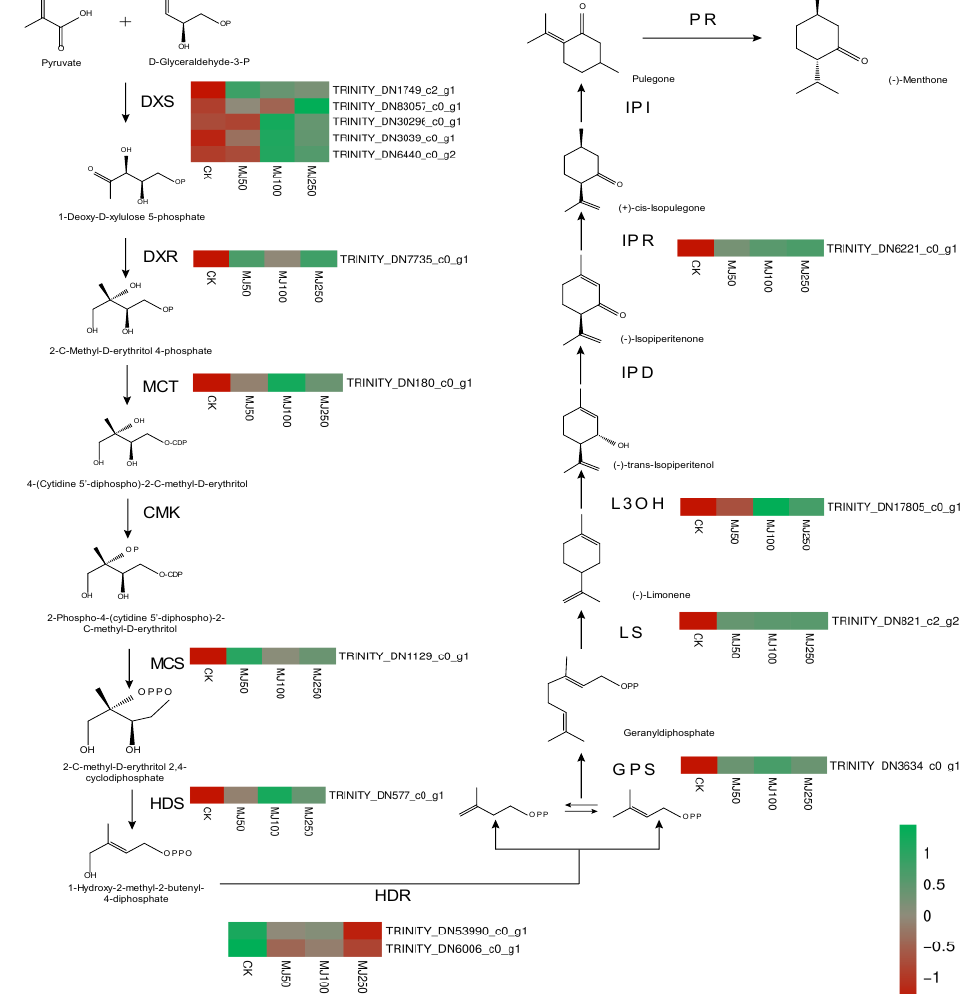
phosphate synthase; HDR 4 − hydroxy − 3 − methylbut − 2 − en − 1 − yl diphosphate reductase; GPS geranyl diphosphate synthase; LS ( − ) − limonene sythnase; L3OH Limonene − 3 − hydroxylase; IPR ( − ) − isopi- peritenone redustase; PR pulegone reductase.